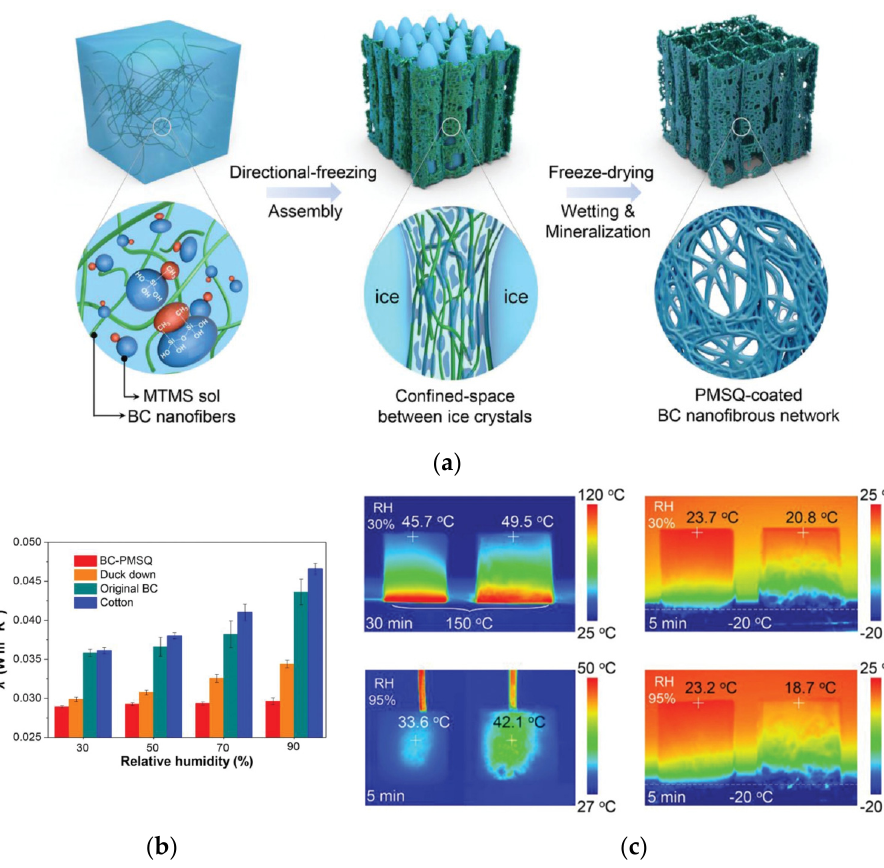
Figure 6. Nanoellulosic hybrid aerogels for thermal insulation. ( a ) Processing principles and synthesis of the BC–PMSQ hybrid aerogels. ( b ) Thermal conductivities λ of BC–PMSQ, down feathers, and pure BC membranes. ( c ) Durable thermal insulation performance was evaluated by optical and infrared images. Adapted with permission from Ref. [132], Copyright 2021, Wiley-VCH GmbH.